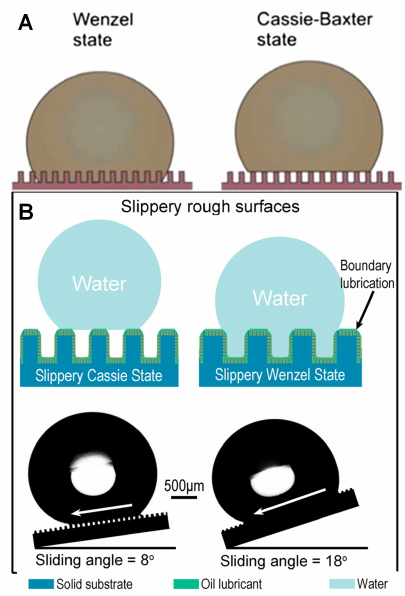
Figure 9. ( A ) Shows droplet in Wenzel (wetted) and Cassie-Baxter regimes (nonwetted); ( B ) Shows design of a hierarchical surface with slippery Wenzel regime through addition of oil lubricant to the pillars. Reprinted with permission from Refs. [79,147], respectively. c (cid:13) 2014 Elsevier; c (cid:13) 2015 American Chemical